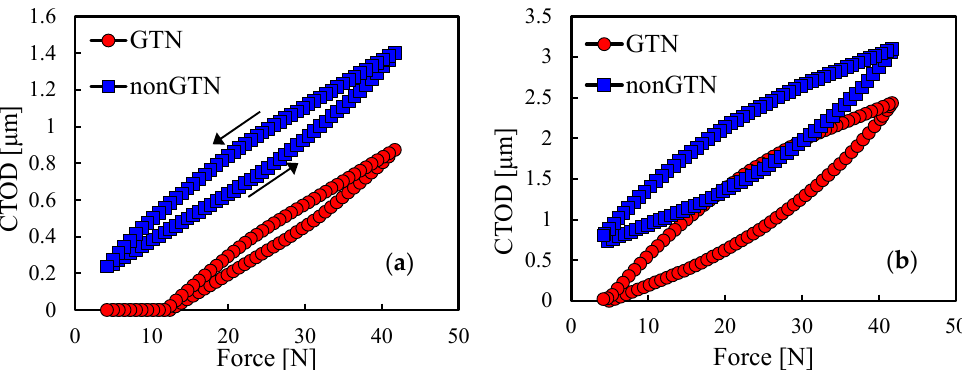
Figure 7. Comparison of CTOD predicted with and without GTN for: ( a ) a 0 = 11.5 mm, at the same load cycle of Figure 4b; ( b ) a 0 = 21.5 mm, at the same load cycles of Figure 5b (plane strain).